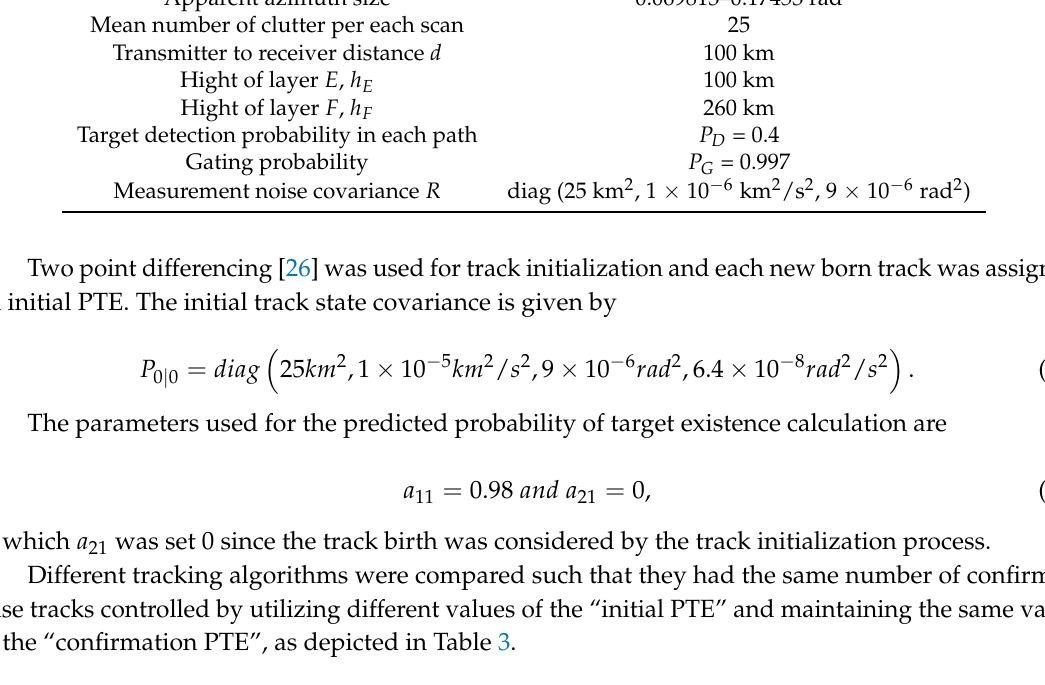
Table 3. Simulation parameters for different algorithms (Scenario